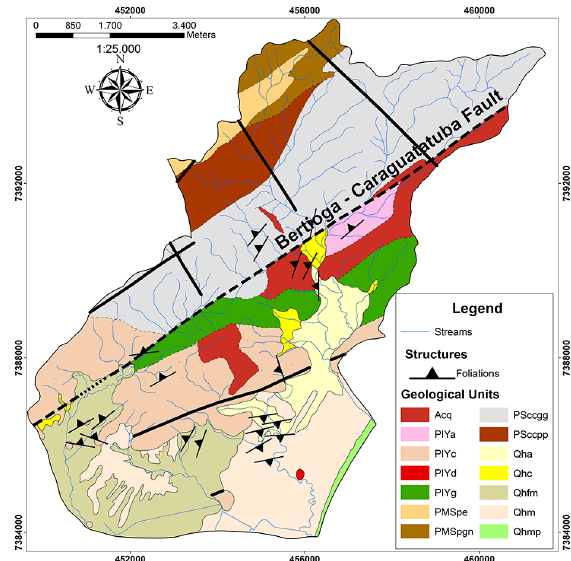
Figure 3 - Geological map of the northeast region of the municipality of Caraguatatuba. The lithologies are: Qha: fluvial sediments; Qhc: coluvial and talus deposits; Qhfm: